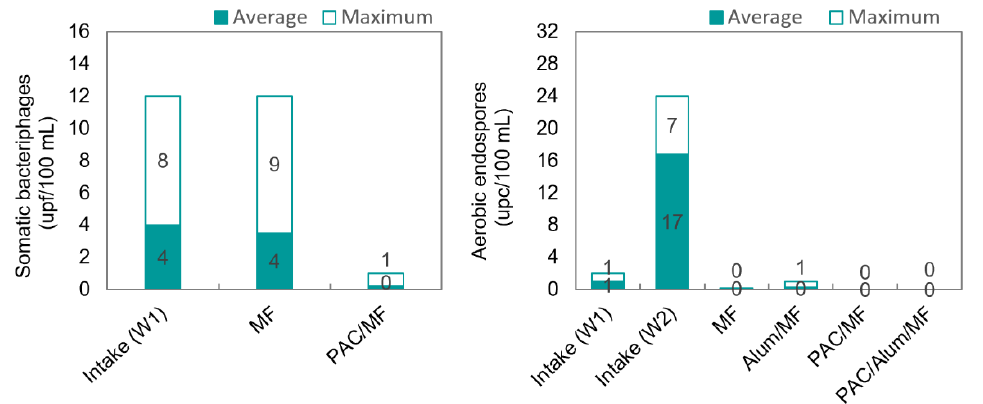
Figure 10. Somatic bacteriophages ( left ) and aerobic endospores ( right ) average and maximum values in pilot intake and permeate waters after ceramic MF, Alum/MF, PAC/MF and PAC/Alum/MF.